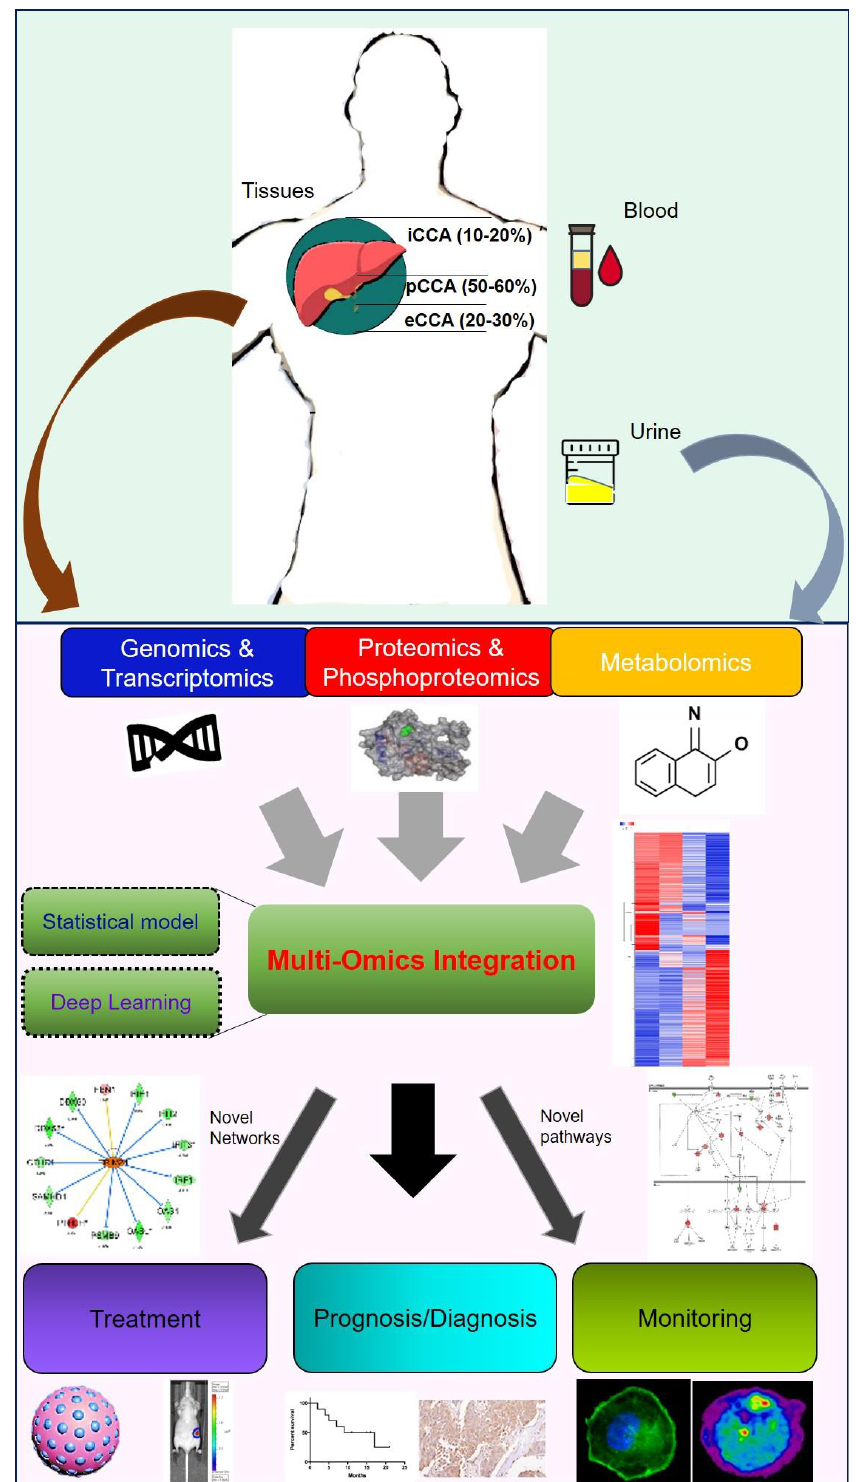
Figure 5. Schematic model of CCA approaches and applications. In this overview, we show several CCA subtypes according to the location of CCA, including intrahepatic (iCCA), perihepatic (pCCA) and extrahepatic (eCCA). We collected previous studies to indicate various mechanisms and experiments in patients’ blood, urine and primary tissue specimens. This schematic model illustrates that omics-based approaches can be used and integrated for further CCA basic and clinical research. In this topic, we input genomics, epigenomics, transcriptomics, proteomics and metabolomics observations for readers.